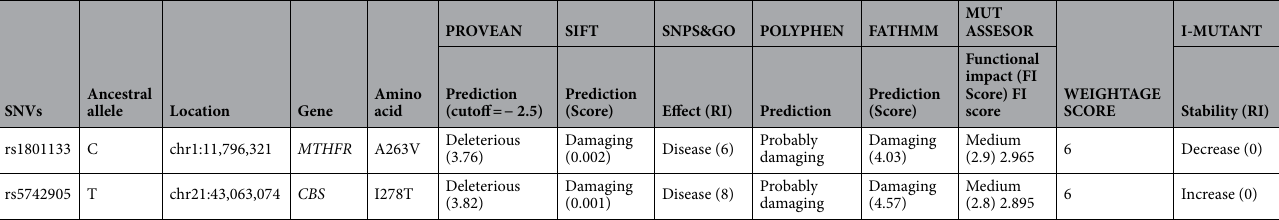
Table 1. List of the prioritized vitiligo associated non-synonymous SNVs.